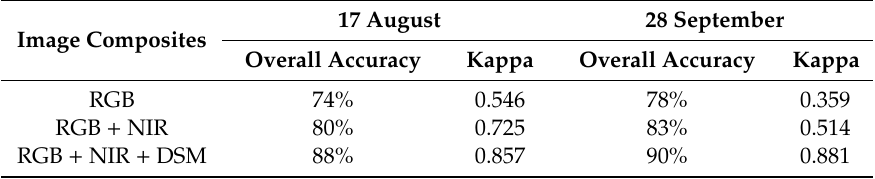
Table 2. Accuracy assessment results for three image composites at the Lucao sampling site. Image